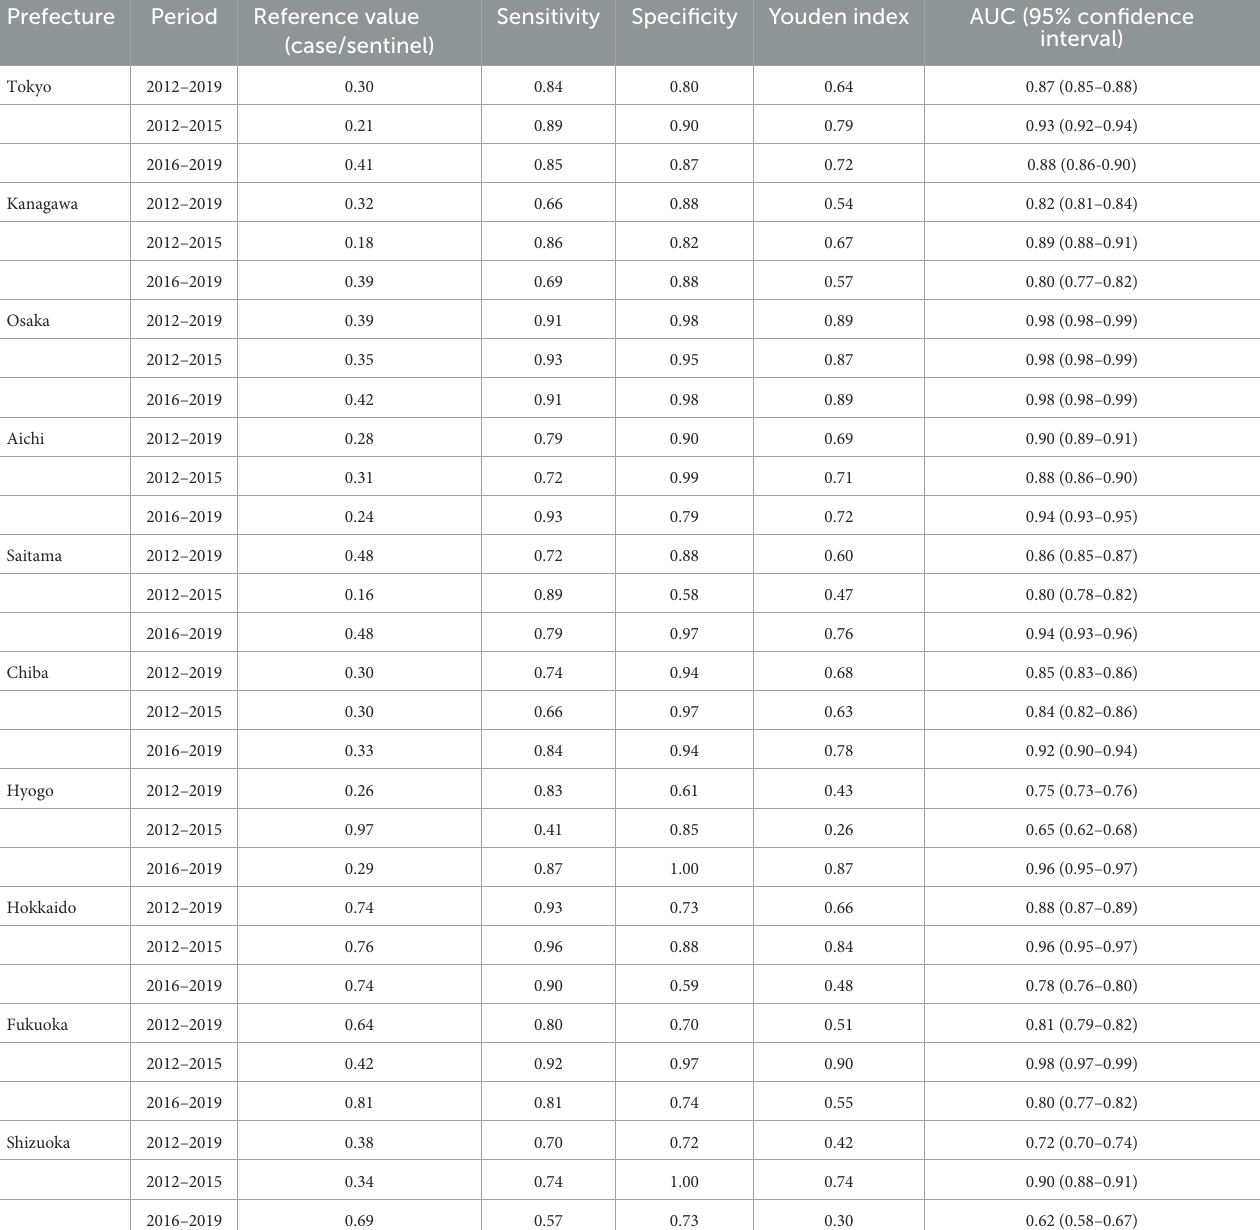
TABLE 1 Reference values using the number of cases per sentinel for the start of the epidemic